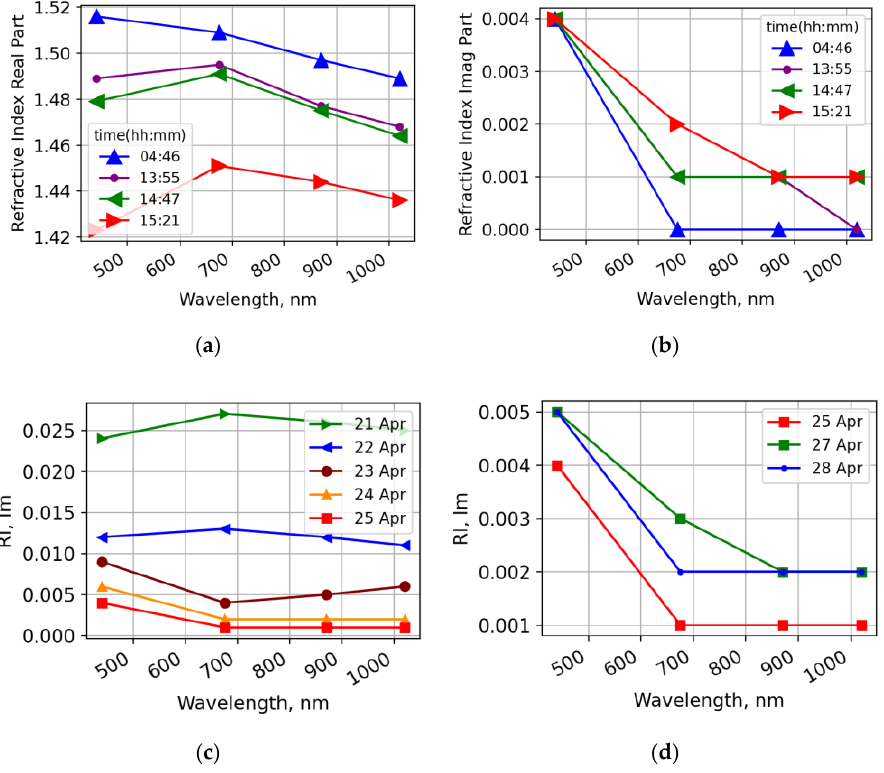
Figure 6. Refractive index: ( a ) real part, ( b ) imaginary part on 25 April 2019, data level 2.0; imaginary part ( c ) 25 April 2019, ( d ) 25, 27, 28 April 2019, data level 1.5. RI values on 26 April 2019 are not available.